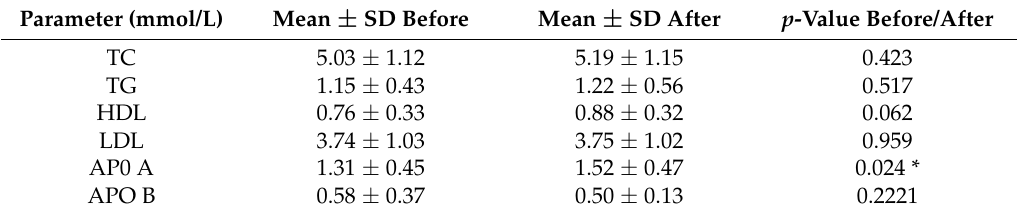
Table 2. Lipid profile including total cholesterol (TC), triglyceride (TG), high and low density